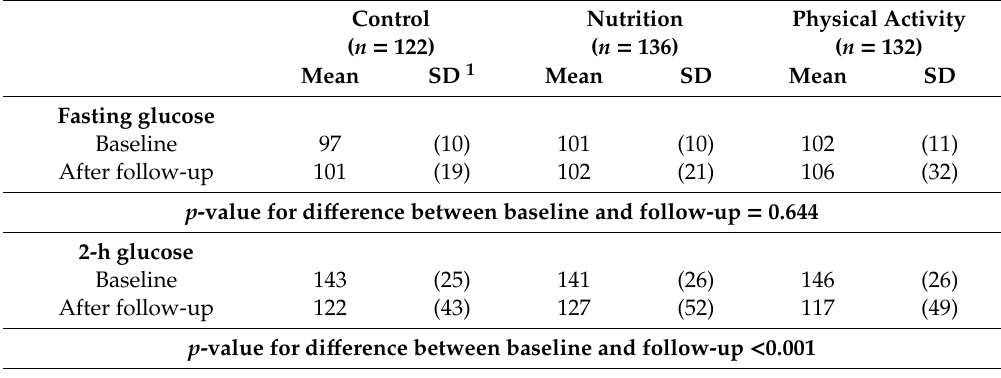
Table 5. Changes in fasting and 2-h glucose levels between baseline and after follow-up, according to intervention